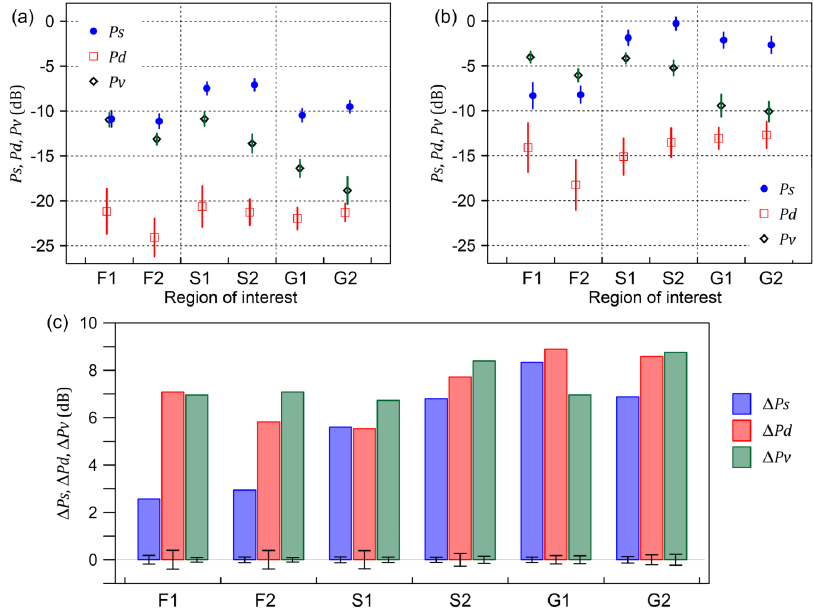
Figure 3. Estimated mean scattering components in the model-based decomposition for the test sites observed in ( a ) frozen and ( b ) thawed conditions. The vertical line indicates one standard deviation; ( c ) the difference between two mean scattering components under frozen and thawed conditions ( µ thawed ´ µ frozen ). The vertical error bars indicate the 99% confidence interval for the null hypothesis H 0 : µ thawed “ µ frozen